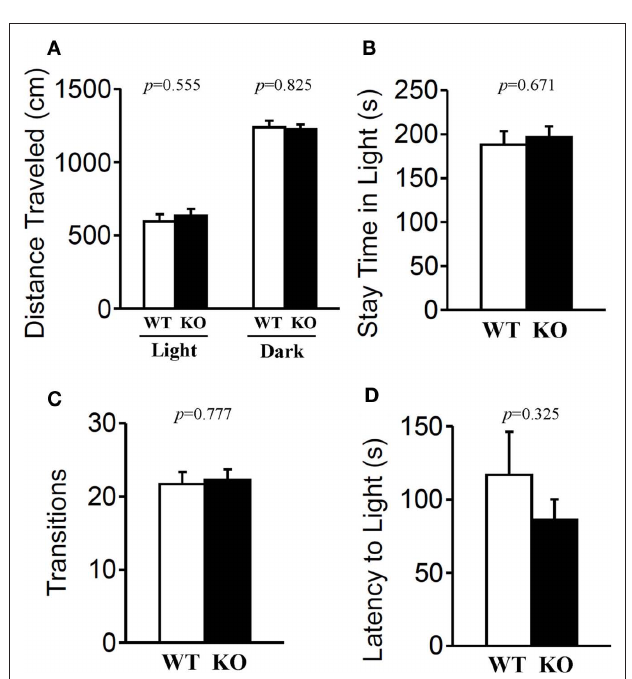
Figure 3 | Light/dark transition test. Wild-type ( n = 19) and relaxin-3 KO ( n = 20) mice were placed individually in the dark compartment at the start of the test. Distance traveled in the light/dark compartments (A) , time spent in light compartment (B) , number of light/dark transitions (C) , and latency to enter the light compartment (D) were recorded. Data are presented as mean ± SEM. p -Values were calculated by Student’s t -test or Mann–Whitney’s U -test.